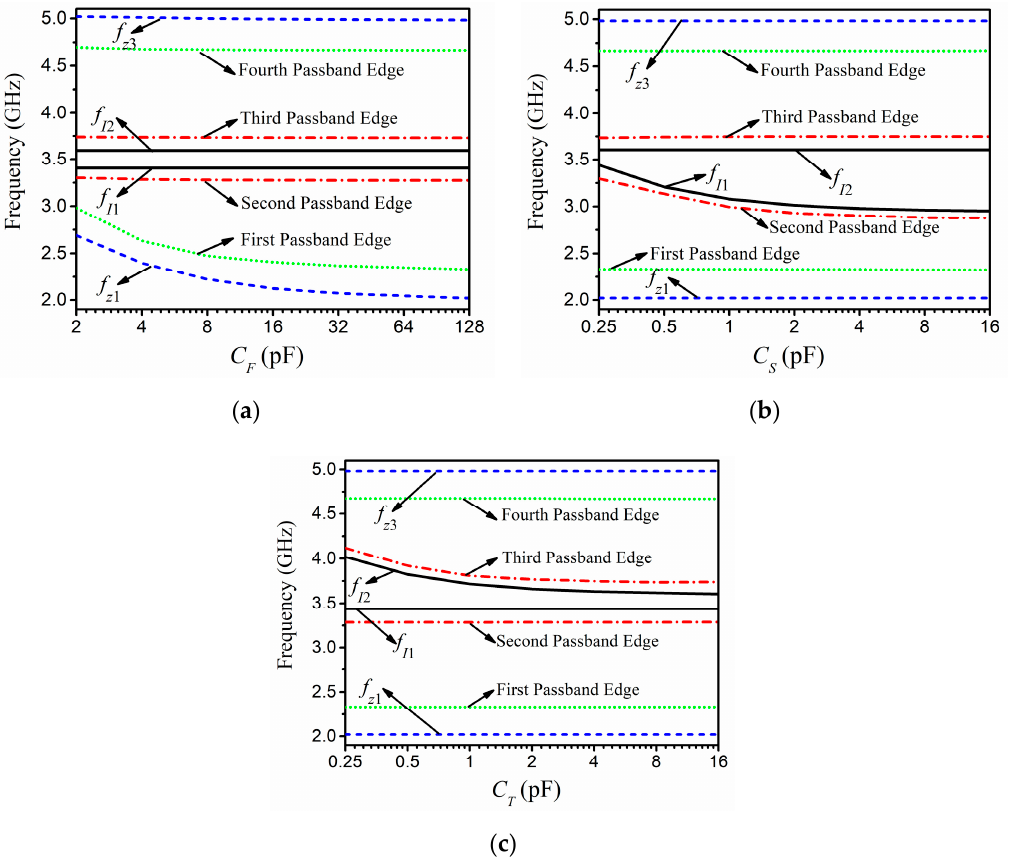
Figure 6. 3-dB passband edges with TZs for sharp skirt with respect to different ( a ) C F ; ( b ) C S ; ( c ) C T .